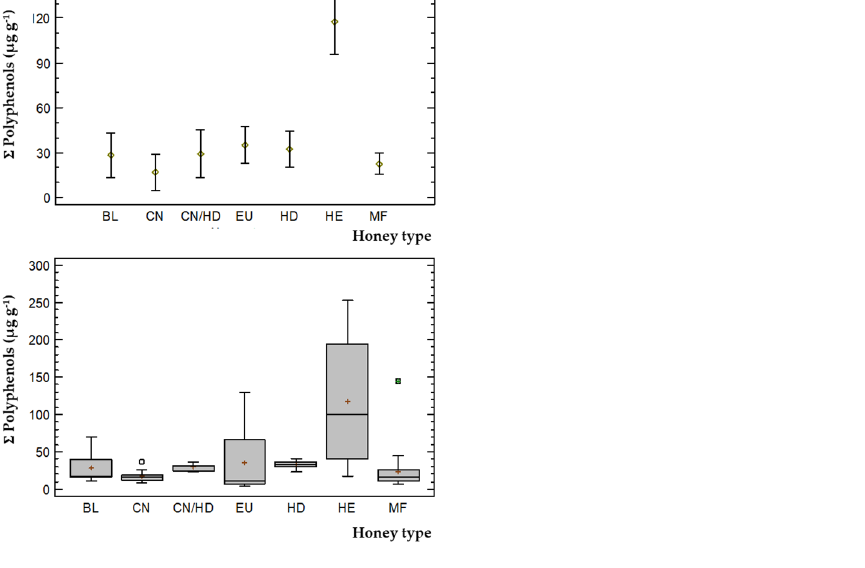
Figure 6. Mean values and box-and-whiskers plots for the different honey varieties based upon the sum of target phenolic compounds concentration.